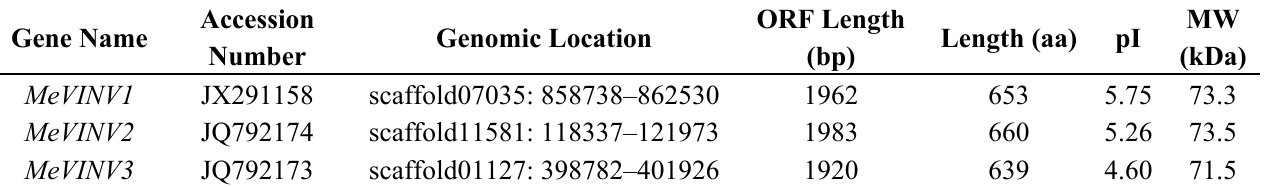
Table 1. Basic information of three cassava vacuolar invertase genes ( MeVINVs ).